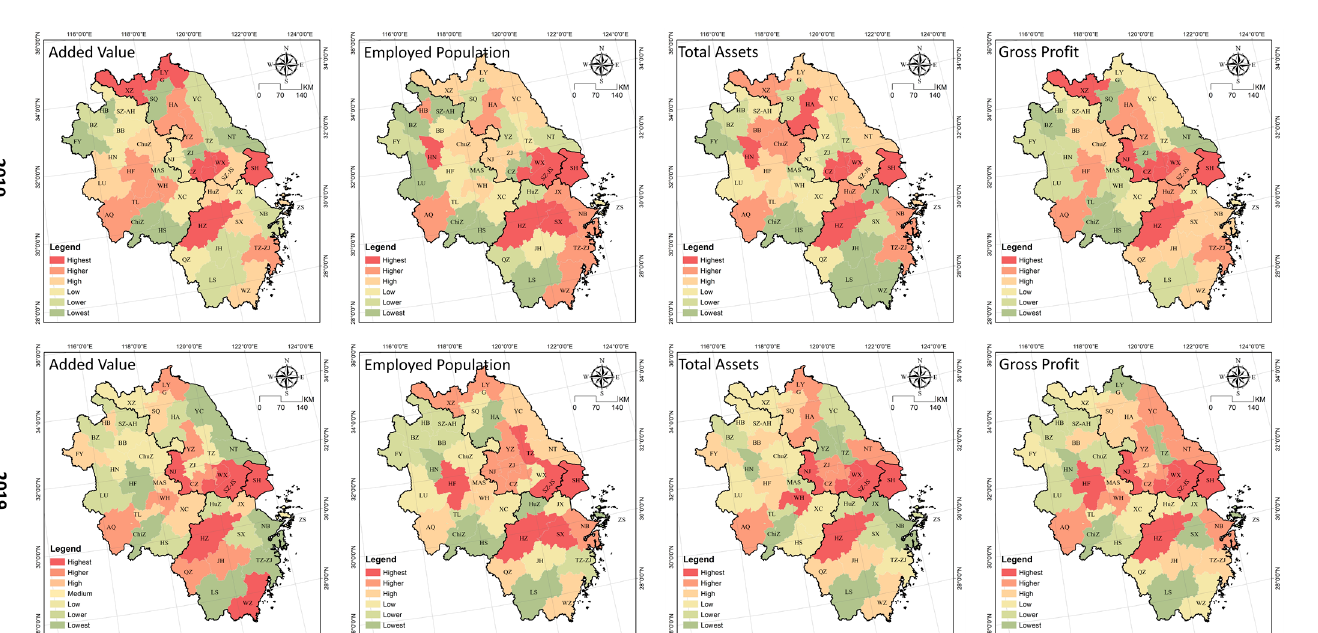
Figure 11. Analysis of the mismatch index contribution rate in the YRD .